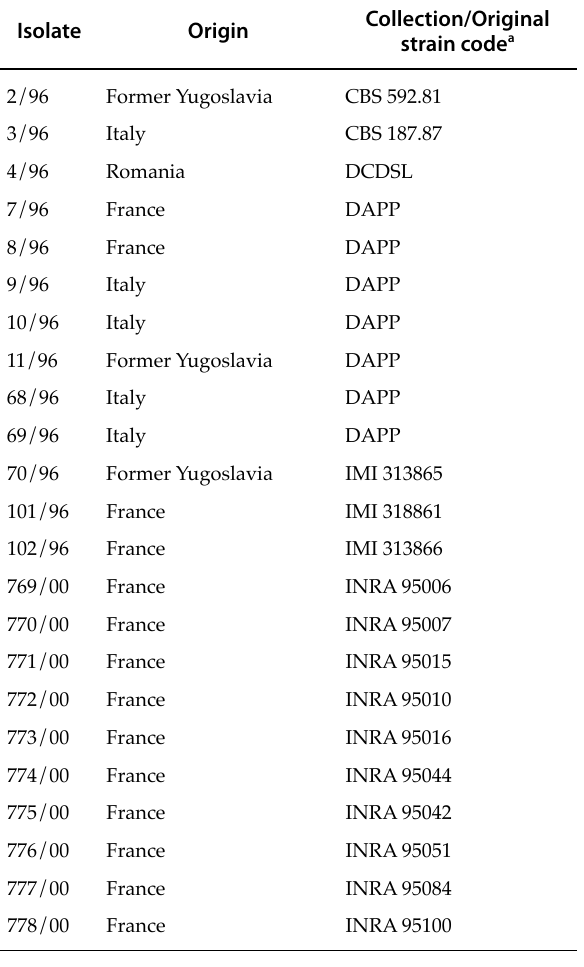
Table 1. Diaporthe helianthi isolates.